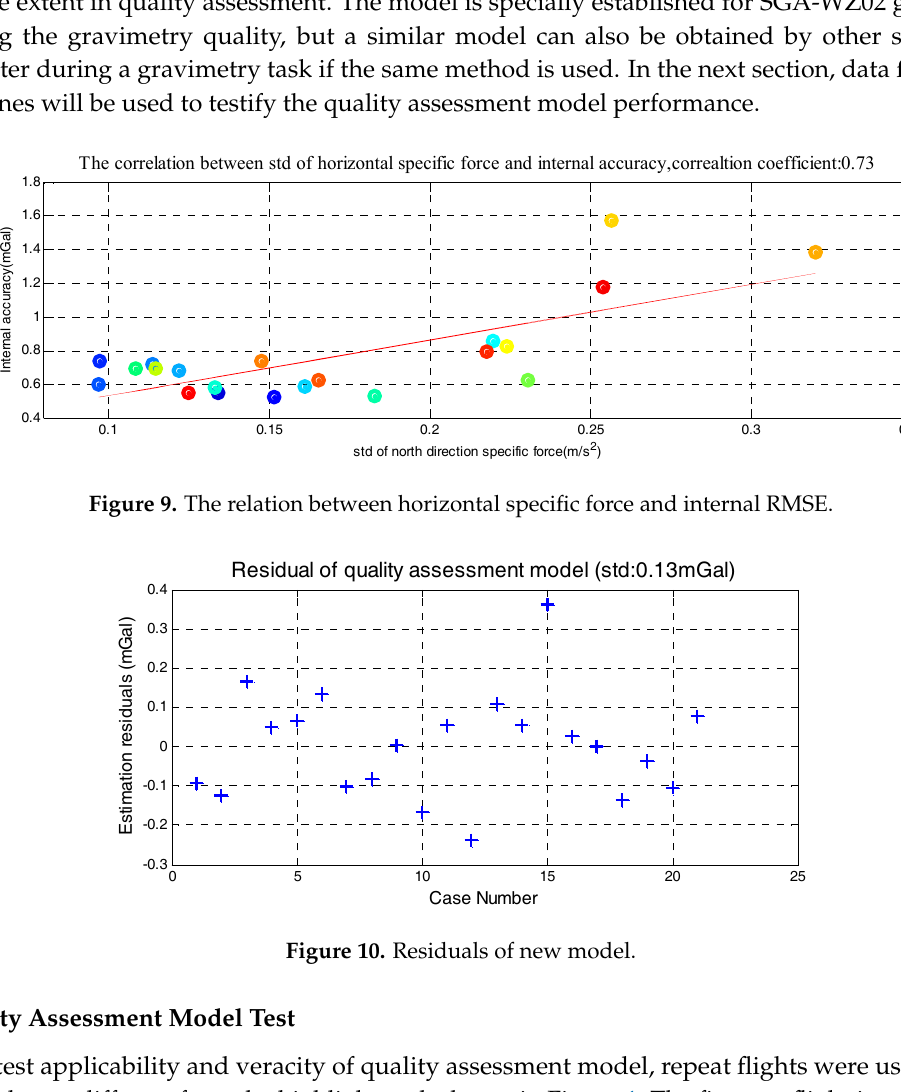
Figure 11. Paths of two repeat line flight.